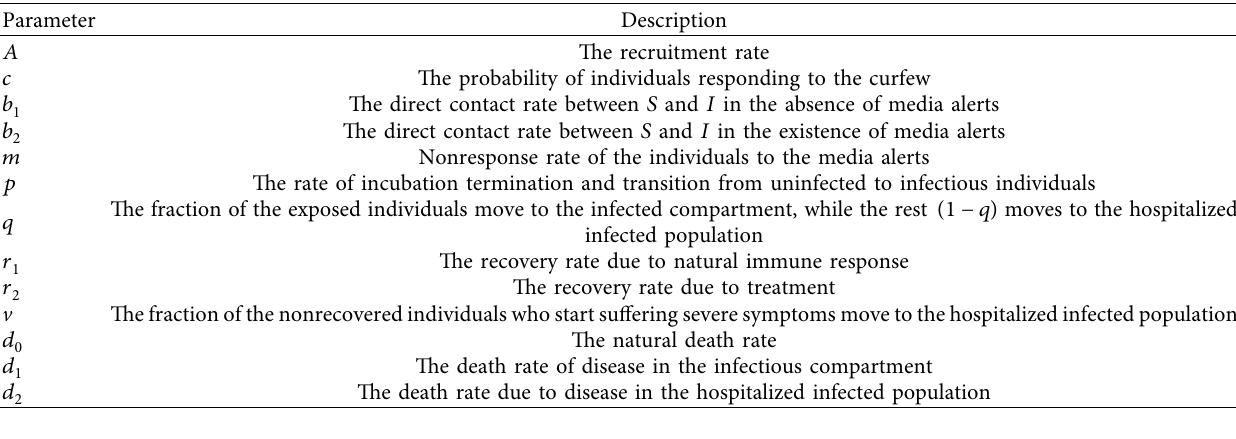
Table 1: The parameters